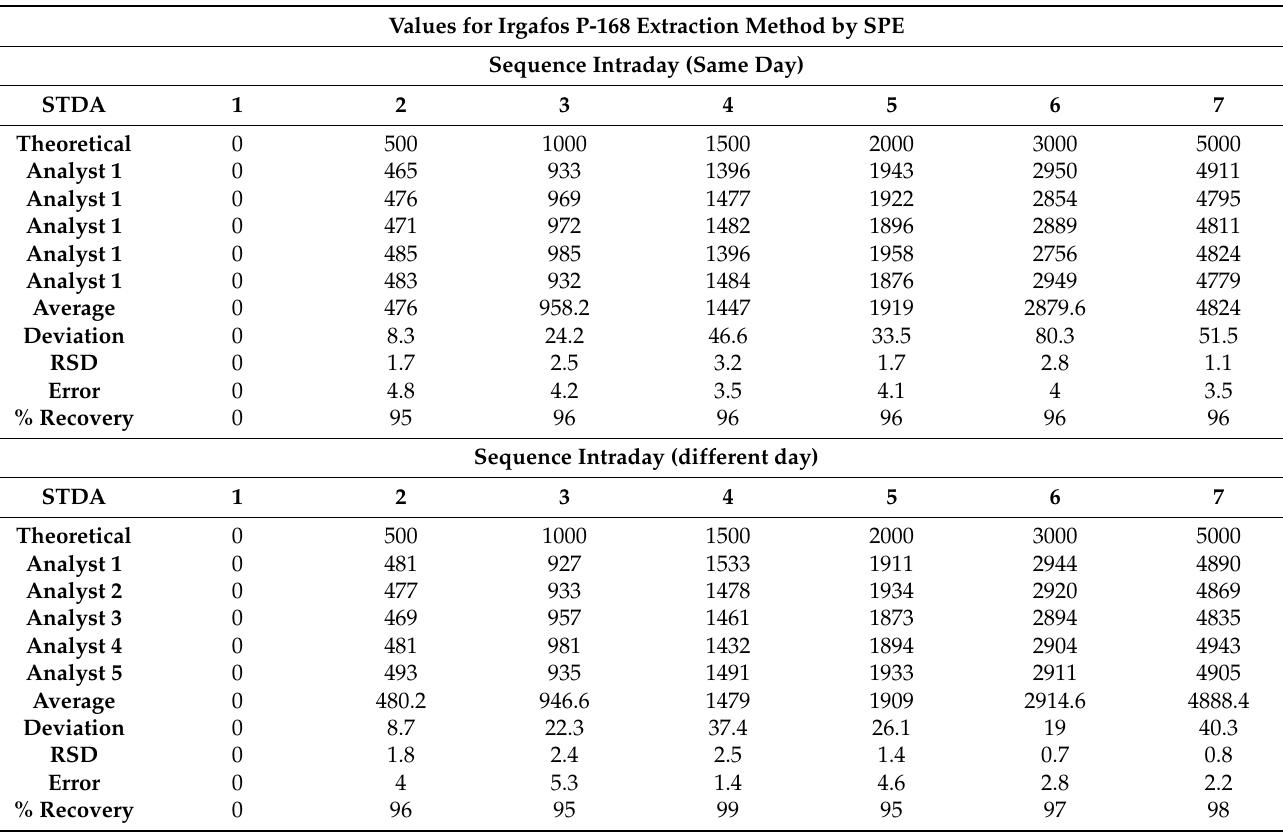
Table 2. Irgafos P-168 repeatability and reproducibility extraction data compilation. Values for Irgafos P-168 Extraction Method by